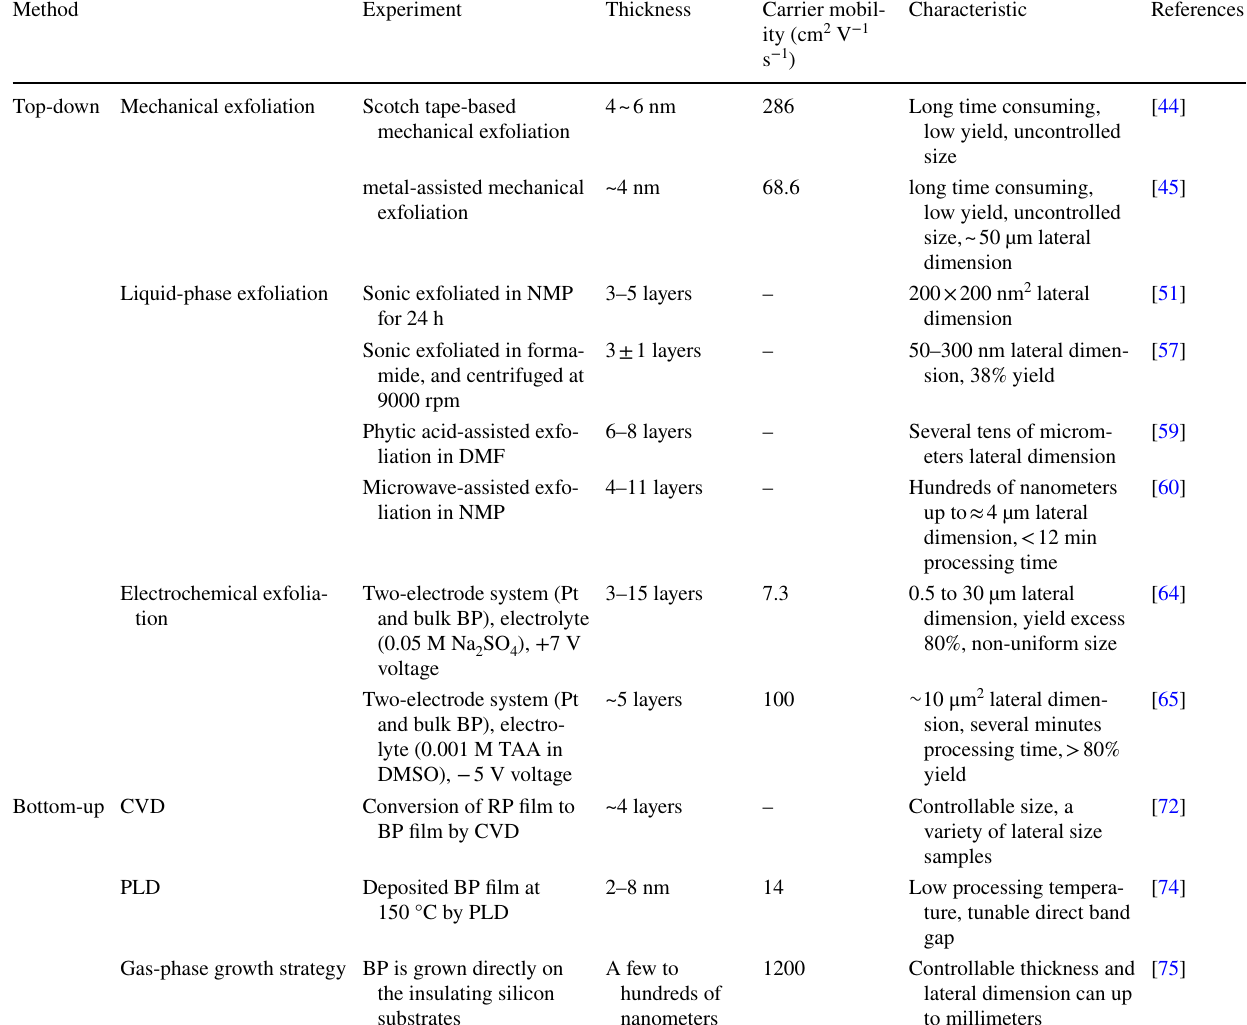
Table 1 The main preparation methods and comparison of phosphorene at present